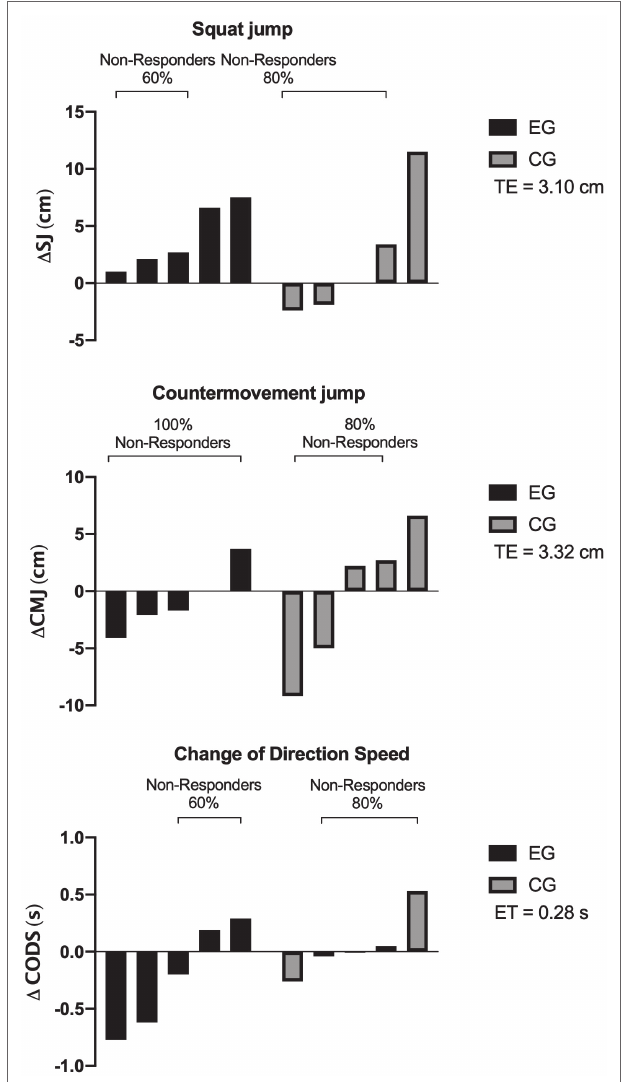
FIGURE 3 | Inter-individual variability analysis of the outcomes analyzed ( n = 10). NRs, non-responders; TE, technical error; Δ , difference post-pre intervention expressed as delta; EG, experimental group; CG, control group; SJ, squat jump; CMJ, countermovement jump; and CODS, change of direction